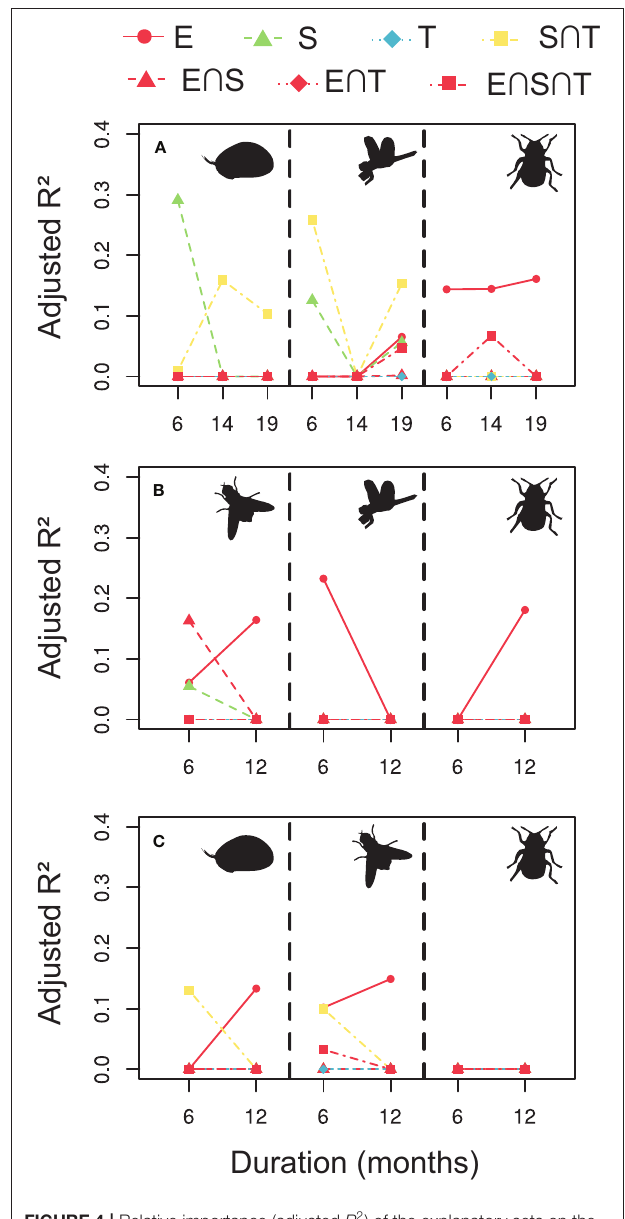
FIGURE 4 | Relative importance (adjusted R 2 ) of the explanatory sets on the variation of the empirical metacommunities in the Stream (A) , Ponds 1 (B) , and Ponds 2 (C) in a gradient of study durations from 6 to 19 months (A) or 6–12 months (B,C) , with six temporal sampling points. In the Stream (A) , we displayed ostracods (left), odonates (center), and coleopterans (right). In the Ponds 1 (B) , we represented dipterans (left), odonates (center), and coleopterans, and in the Ponds 2 (C) , ostracods (left), dipterans (center), and coleopterans